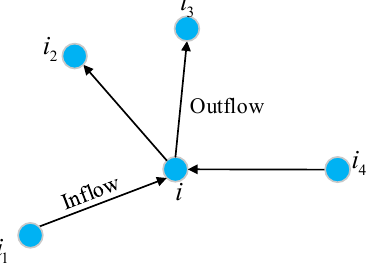
are the active and reactive power at the outflow end of line li , respectively. and